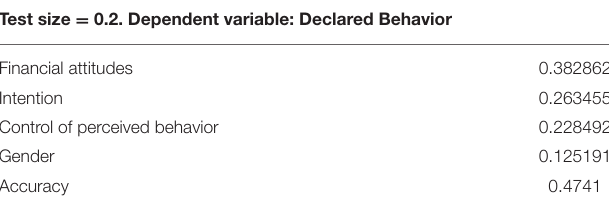
TABLE 7 | Random Forest classification model for the variable declared behavior . Random forest classification